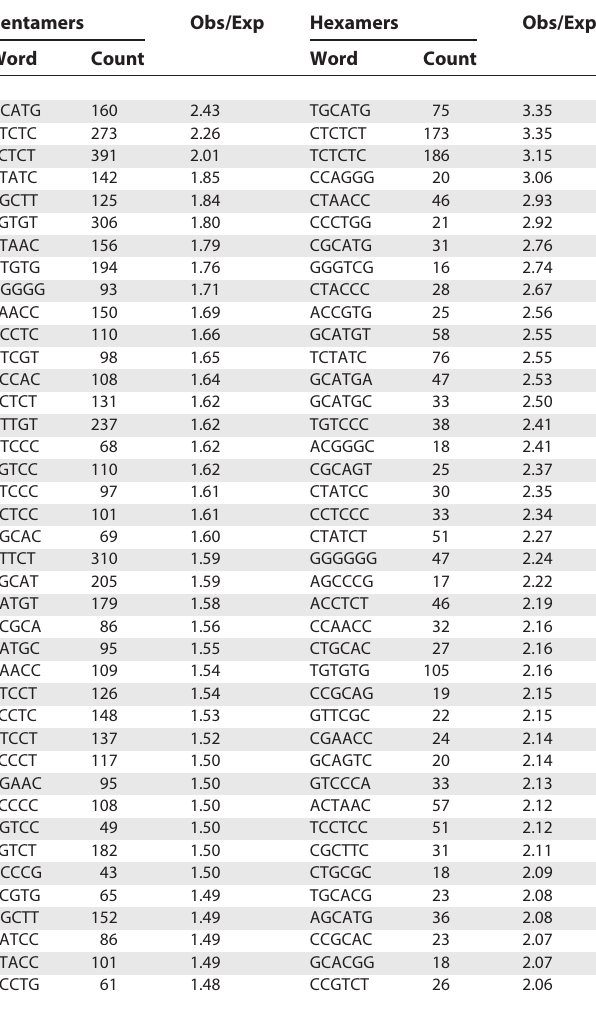
Table 1. Pentamer and Hexamer Sequence Motifs That Occur More Frequently in Conserved Intronic Elements Flanking Alternatively Spliced Exons than in the Total Intron Dataset